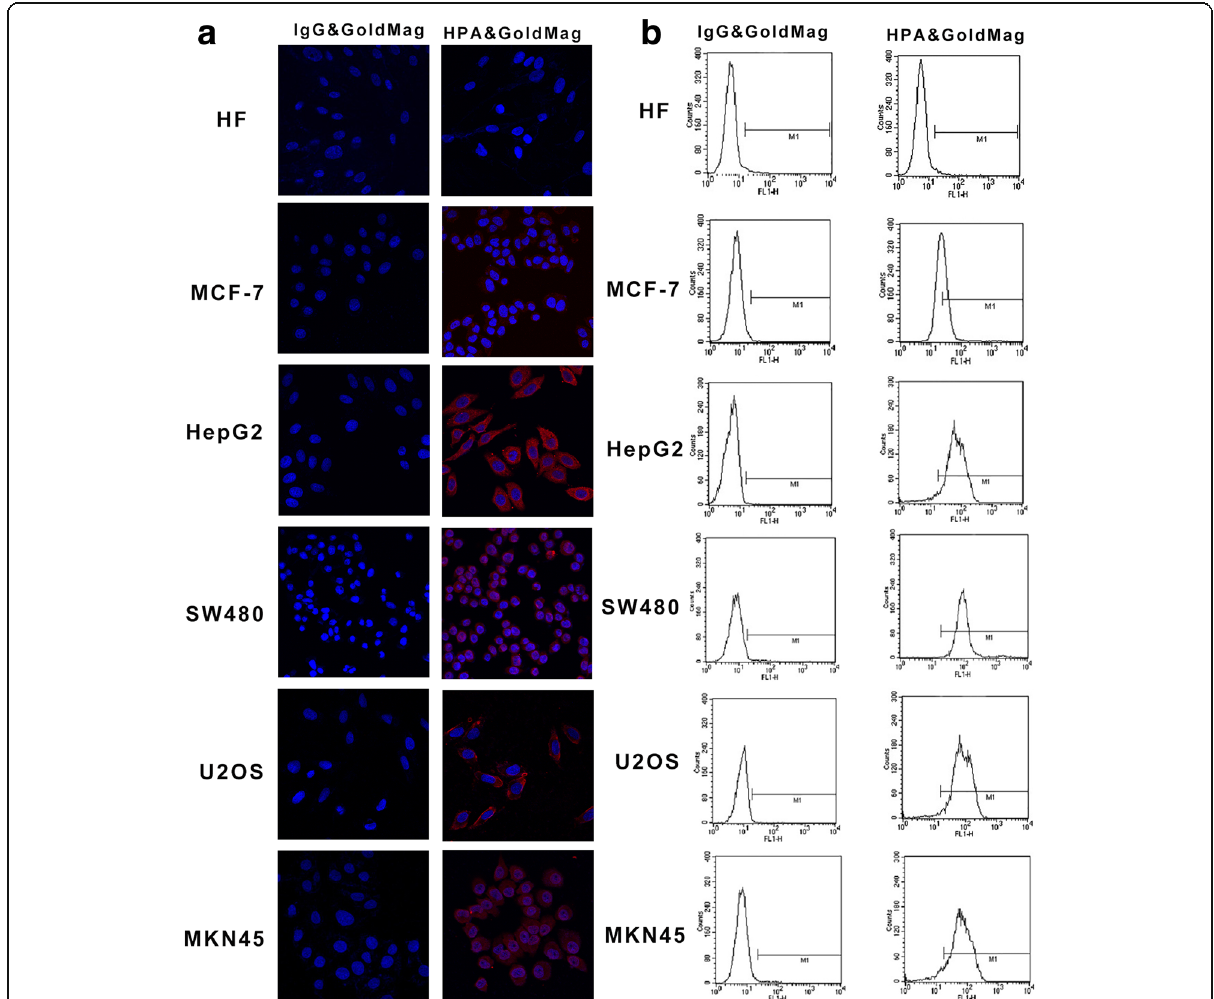
Fig. 3 Specificity and binding activity of the probe detected by immunofluorescence and flow cytometry. a Immunofluorescence was performed using probes as indicated. b Flow cytometry was used to test the specificity of the HPA&GoldMag molecular